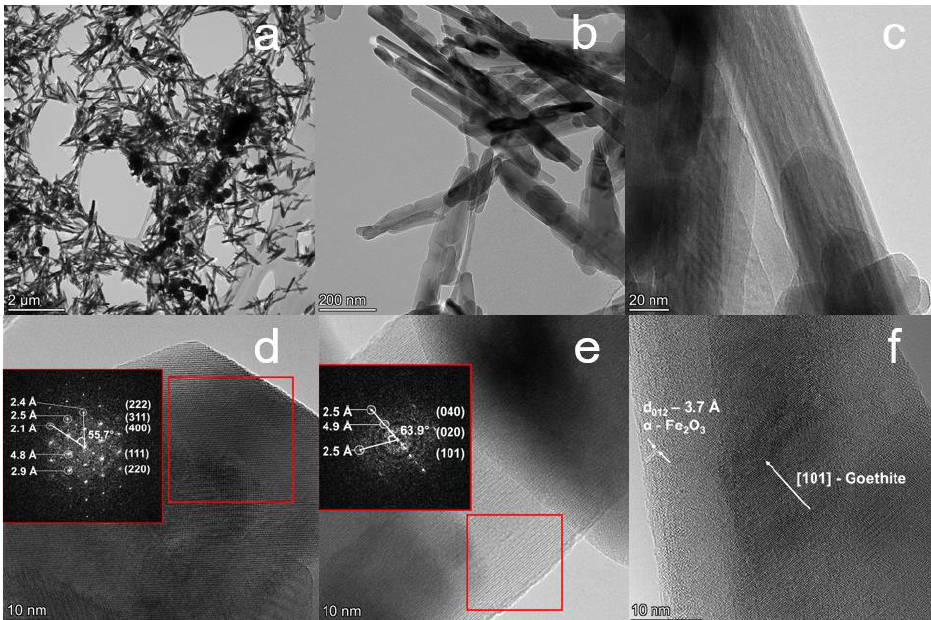
Figure 5. TEM micrographs of the sample obtained during the synthesis for 12 h: ( a , b ) survey im- ages of synthesized nanoparticles; ( c ) HRTEM image of micro pores in ANPs of α-FeOOH; ( d ) HRTEM image of isotropic Fe 3 O 4 particles; ( e ) HRTEM image of anisotropic α-FeOOH particles; ( f ) HRTEM image of α-Fe 2 O 3 layer on the α-FeOOH particle (red insets show FFT-images with calcu- lations of interplanar spacing).